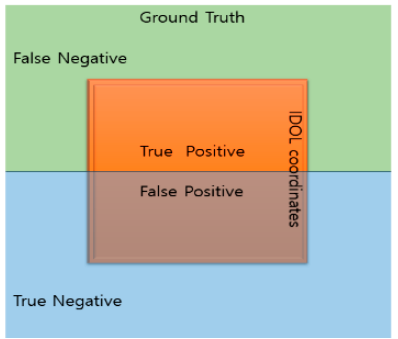
Figure 13. Confusion matrix for object localization results.